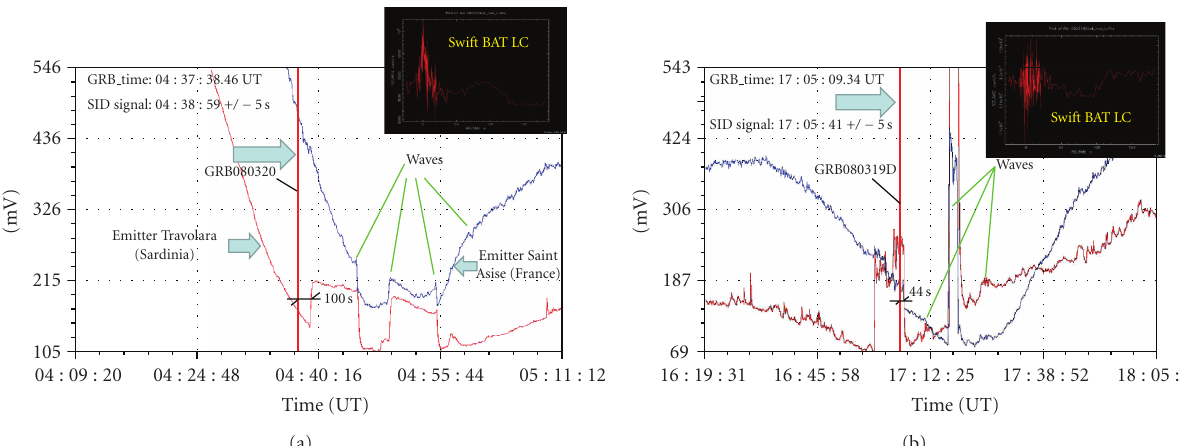
Figure 15: The probable detection of GRB080319D (a) and GRB080320A (b) with indicated probable propagating ionospheric waves caused by the